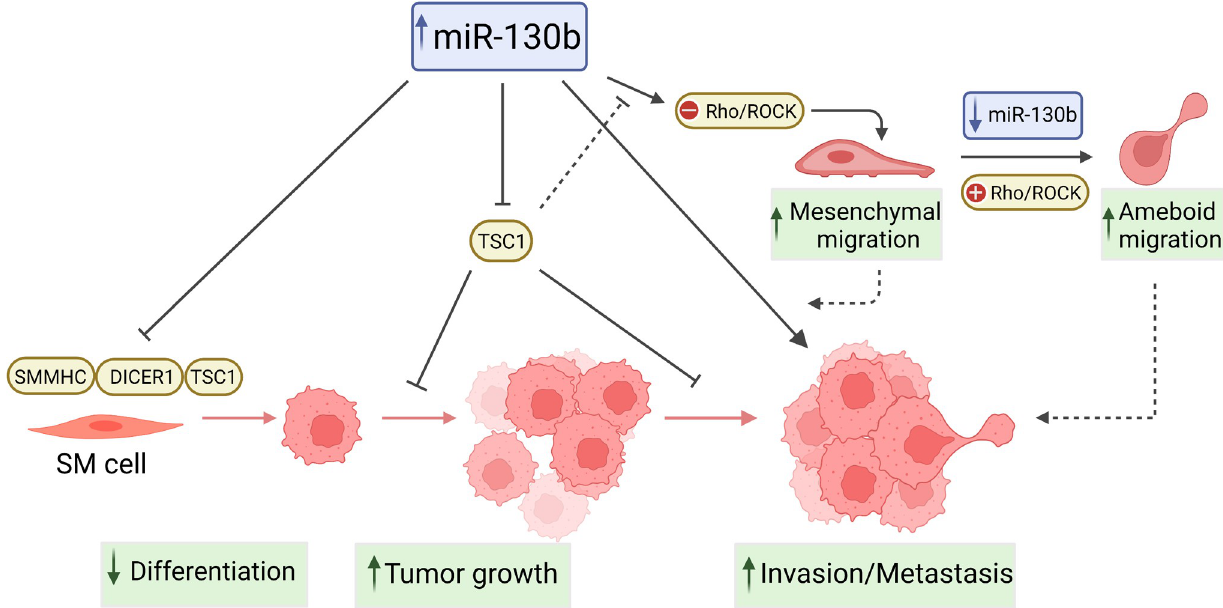
Fig 7. Proposed tumorigenic mechanisms of miR-130b in LMS. Solid lines indicate demonstrated interactions; dashed lines represent hypothetical associations with tumorigenic mechanisms.